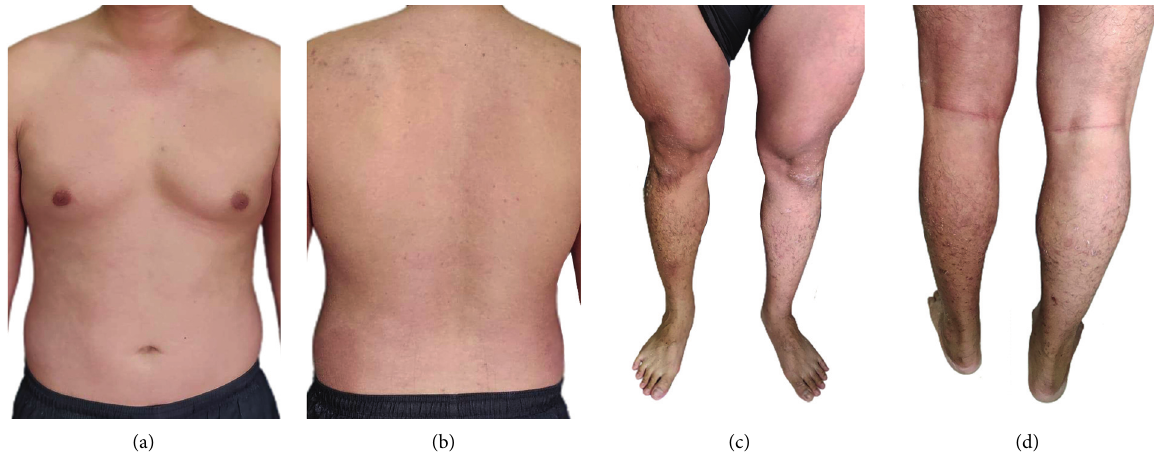
Figure 3: Recovery of the skin lesions from generalized erythema at the upper body: (a) front and (b) back and lower body: (c) front and (d) back were close to